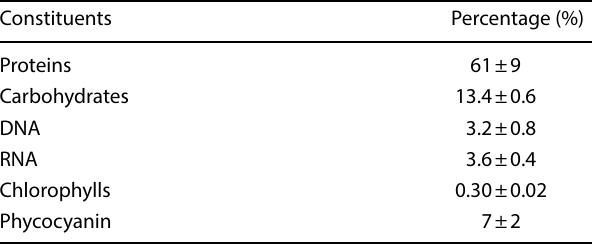
Table 1 Constituents of edible biomass